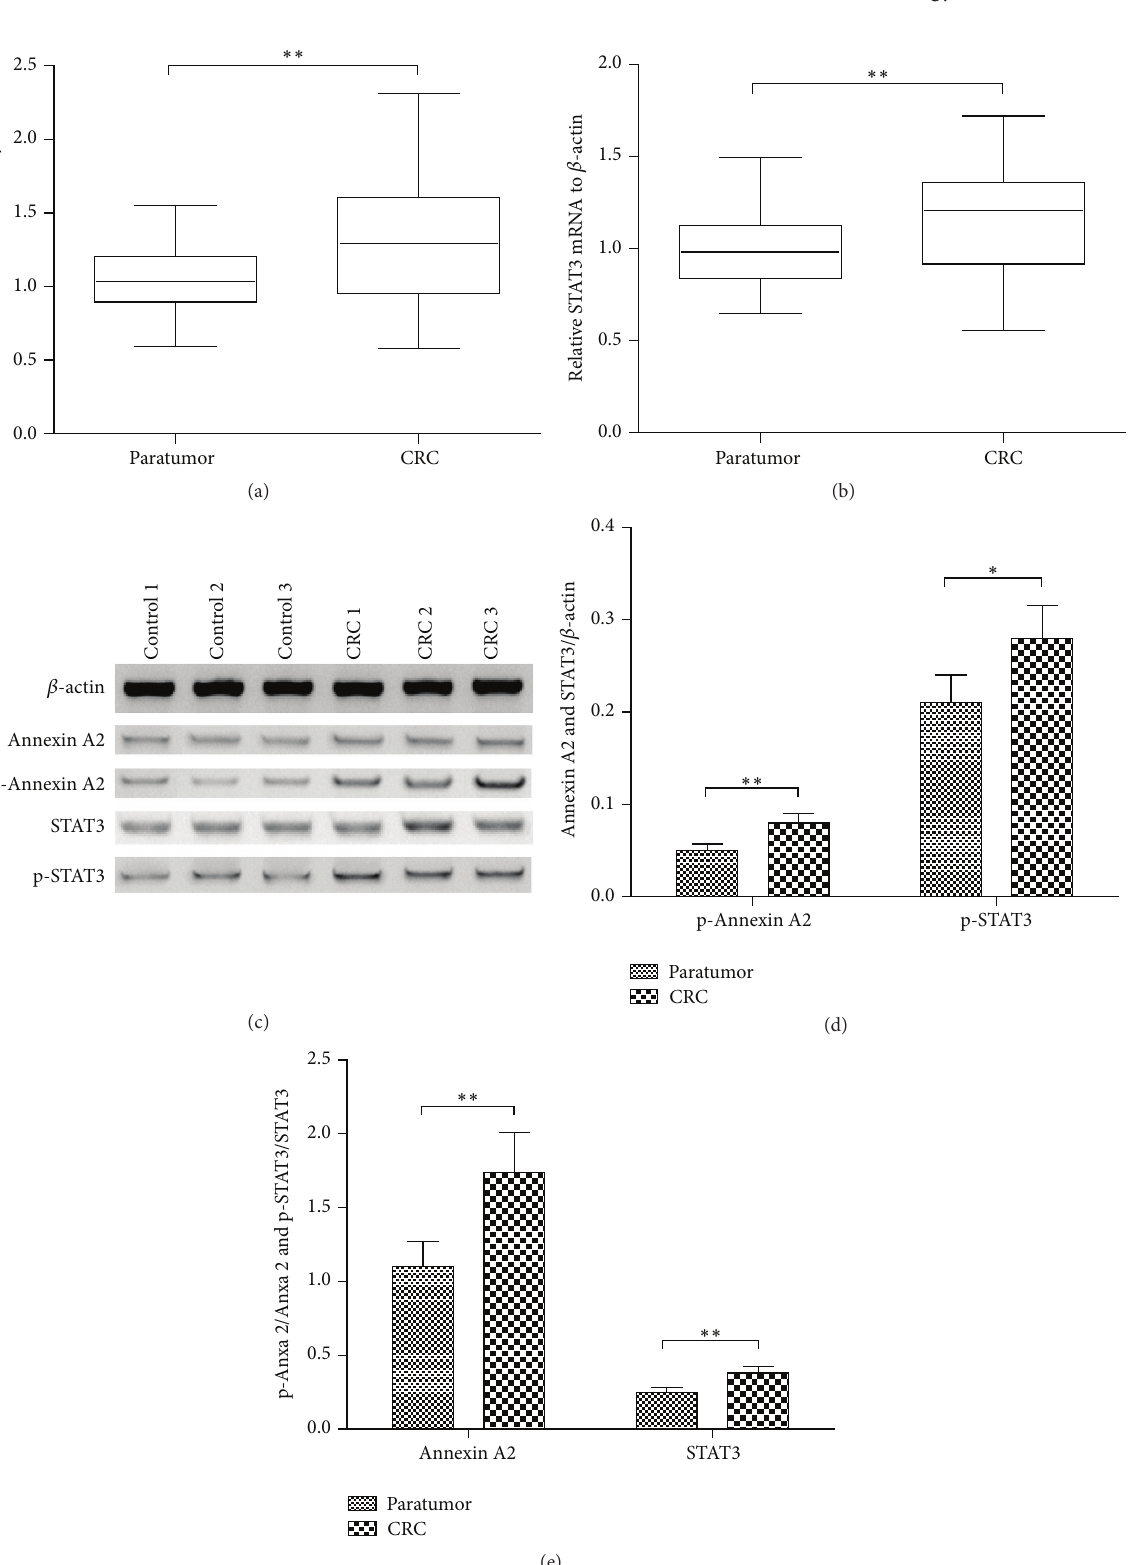
Figure 1: Comparisons of the expression and the phosphorylation of Annexin A2 and STAT3 between the colorectal cancer (CRC) tissue and the paratumor tissue. (a) and (b) The expression of Annexin A2 (a) and STAT3 (b) in mRNA level was assayed in CRC tissues ( 𝑛 = 35 ) and in paratumor tissues ( 𝑛 = 35 ) by relative qRT-PCR analysis; (c) representative western blot analysis of the expression in protein level and the phosphorylationofAnnexinA2(Tyrosine23)andSTAT3(Tyrosine705)inCRCtissues( 𝑛 = 15 )andinparatumortissues( 𝑛 = 15 );(d)relative level of Annexin A2 and STAT3 to 𝛽 -actin in protein level; (e) relative Annexin A2 and STAT3 with phosphorylation to nonphosphorylated Annexin A2 and STAT3. ∗ and ∗∗ represented 𝑝 < 0.05 and 𝑝 < 0.01 ,